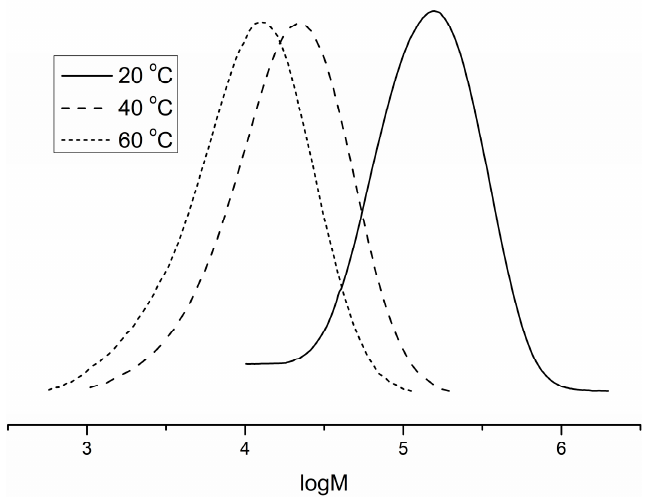
Figure 2. GPC curves of polymers under different polymerization temperatures.